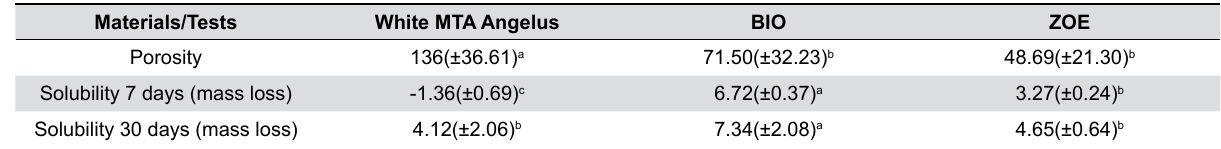
Table 1- Mean and standard deviation of the results of solubility (%) and porosity (number of pores) of root repair cements evaluated after immersion in distilled water